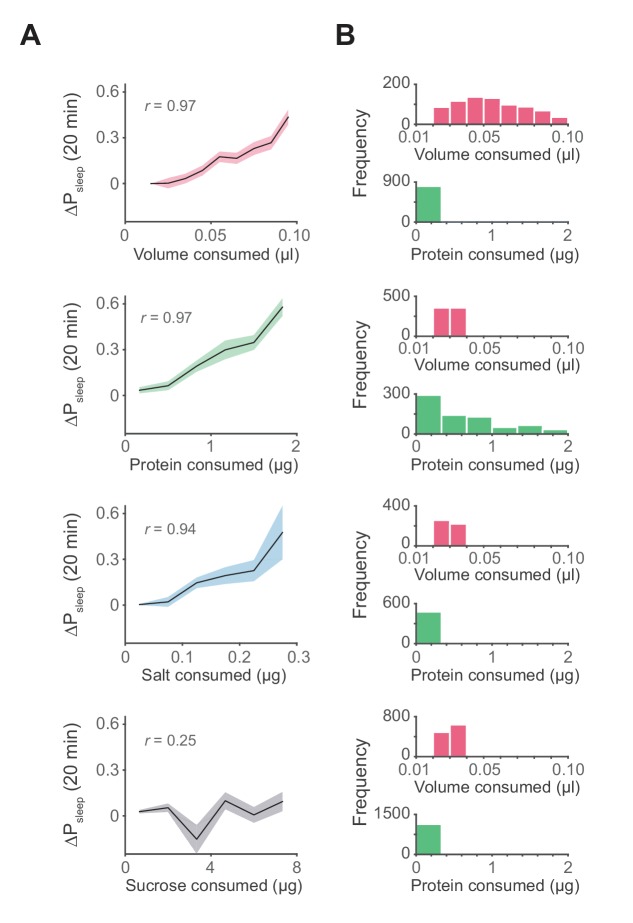
Influence of meal components on postprandial sleep.(A) Average 20 min ΔPsleep as a function of each meal component (Canton-S, Pearson correlation: p<0.001, volume; p<0.001, protein; p<0.005, salt; p=0.065, sucrose). Shaded lines represent mean ± s.e.m. (B) Histograms representing the distribution of volume and protein consumed in each meal for data from A.